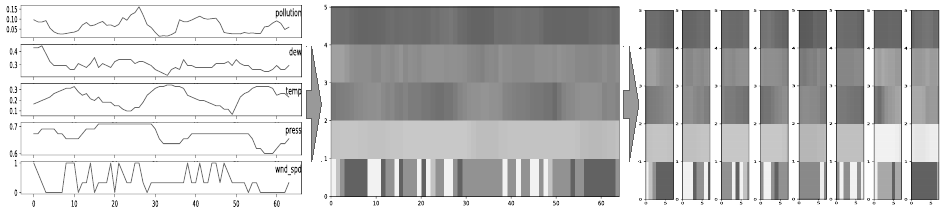
Figure 5. Example of input segmentation for the ConvLSTM2D